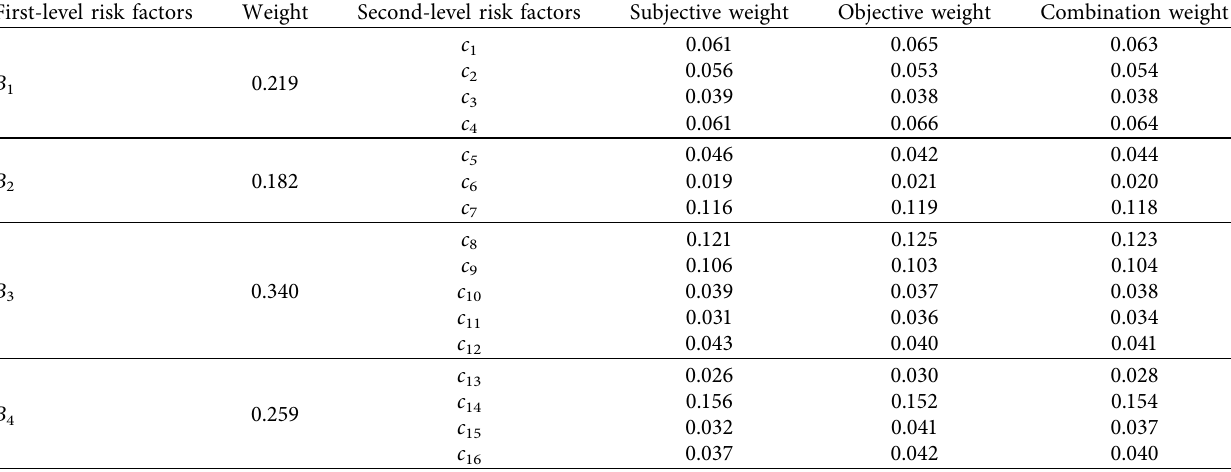
Table 5: Weights of C